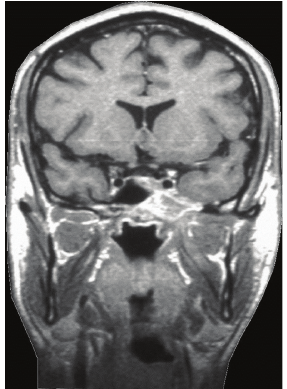
Figure 3: Cranial MRI 5 weeks after radiotherapy.